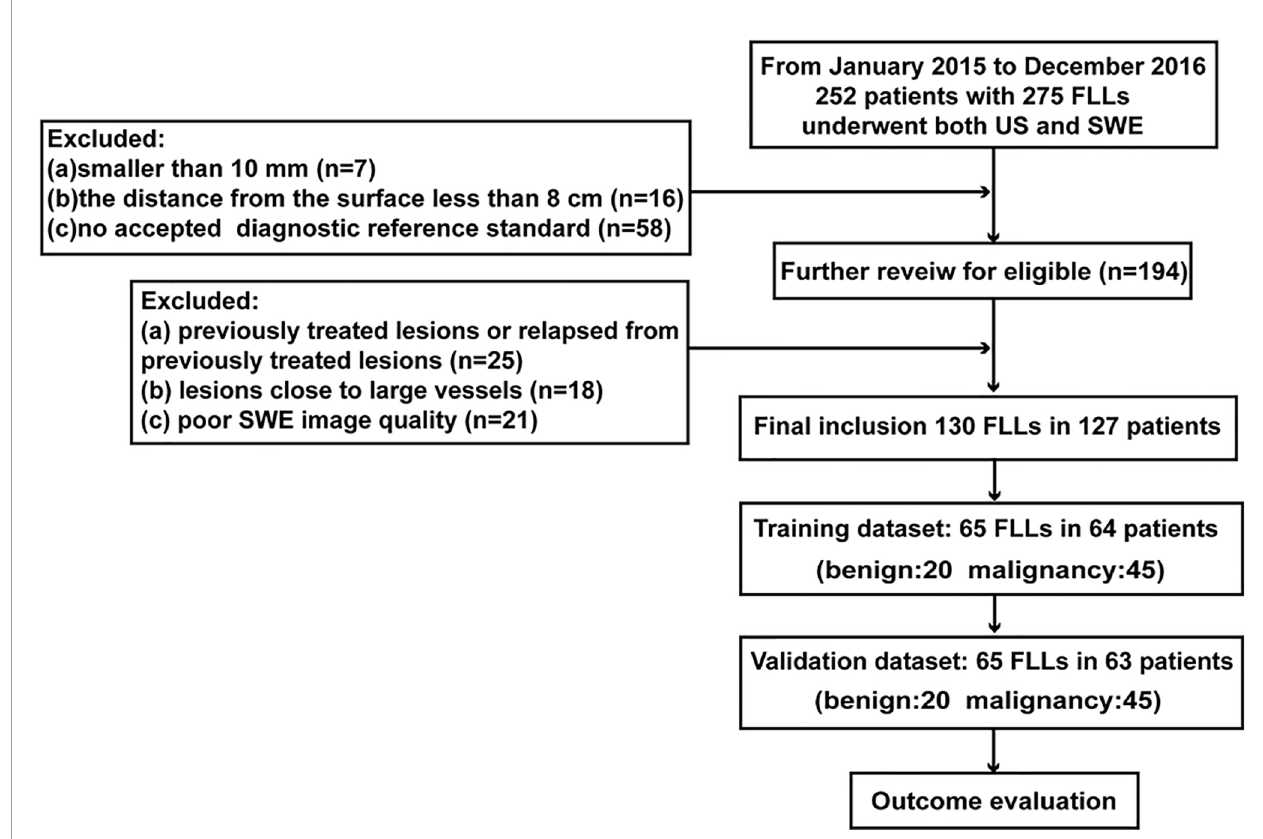
FIGURE 1 | Inclusion fl ow chart for the study